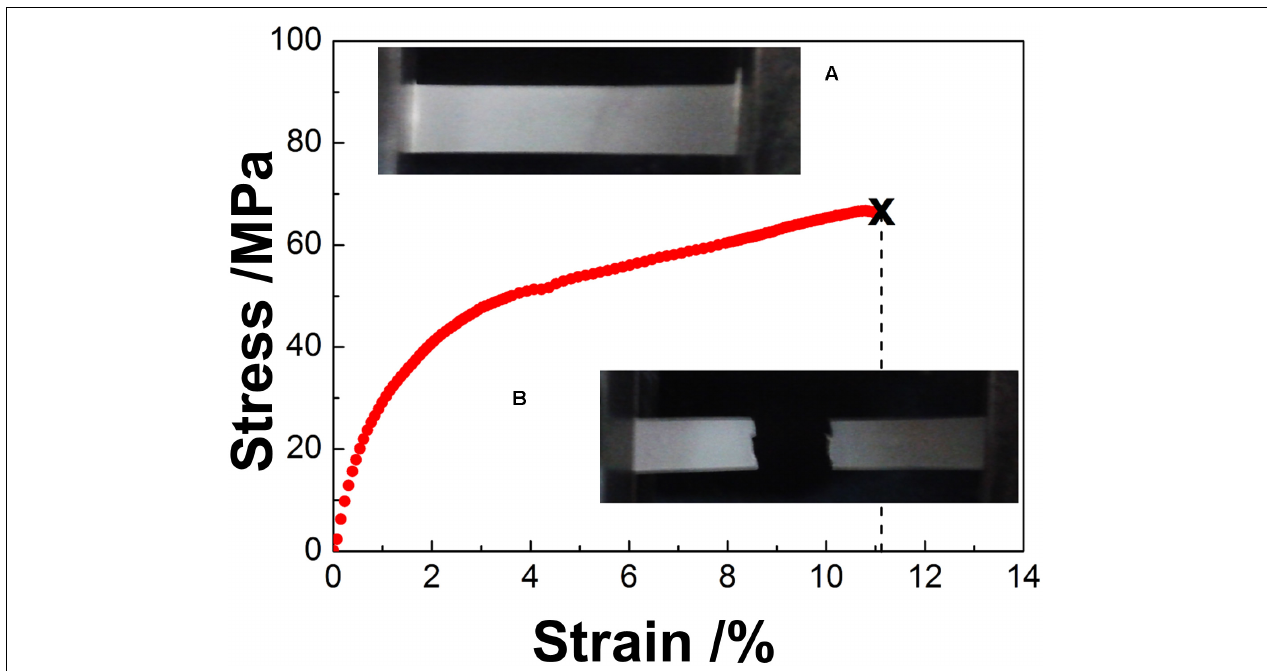
FIGURE 3 | Stress-strain curve of CSE [inset: digital photographs of (A) beginning of the test and (B) after fracture].